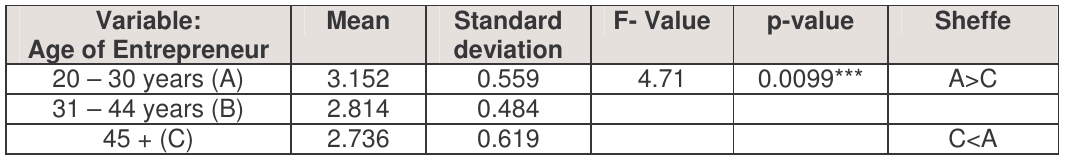
Table 4: ANOVA between different age groups of entrepreneurs regarding effective time